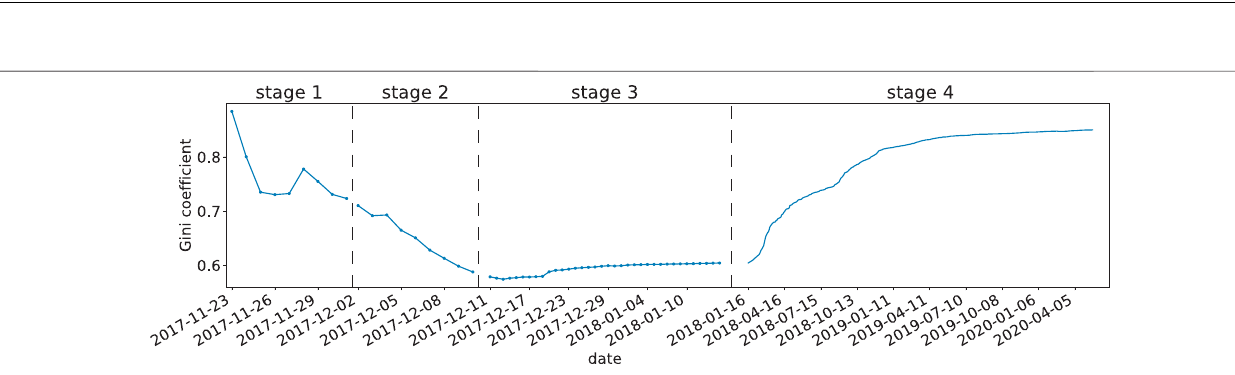
FIGURE 11 | Gini coef fi cients of (A) daily selling and lending revenue and (B) the accumulate revenue from kitty sale and renting for all the addresses. Dotted lines separates the stage 1, 2 and 3.